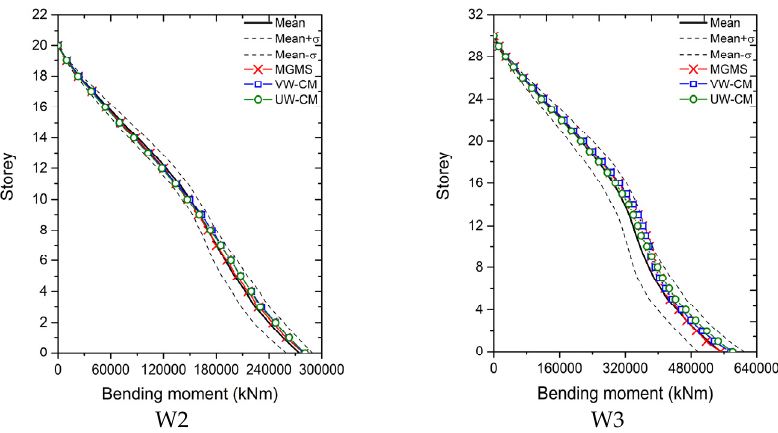
Figure 7. Comparison of the bending moment.